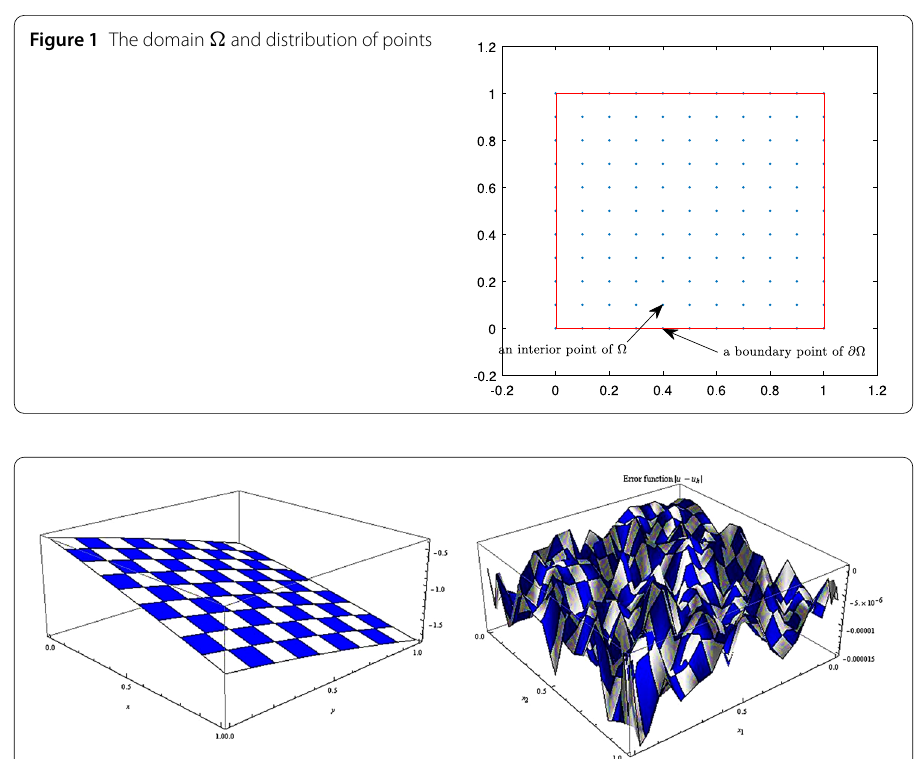
Figure 2 Graphs of the SMRPI solution and the error with h = 1/32 for Example